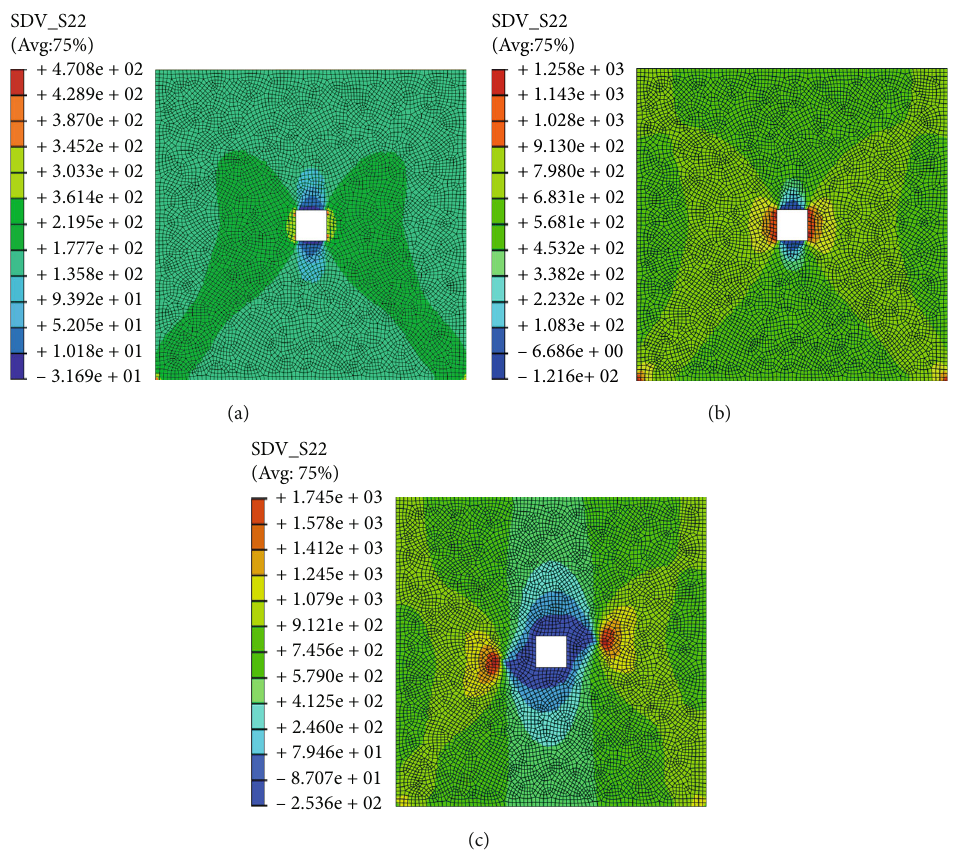
Figure 9: The vertical stress when the crack grows. (a) Crack initiation stage. (b) Crack initiation stage. (c) Crack development